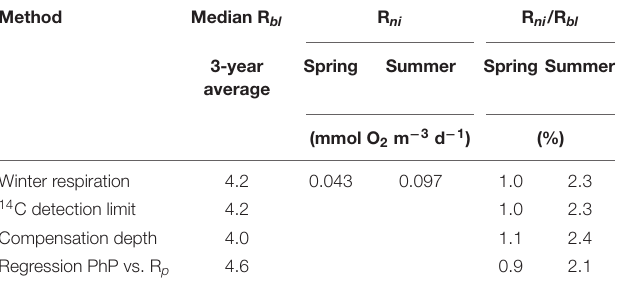
TABLE 3 | Integrated rates for the whole volume of the estuary (0.77 km 3 ) per year or per winter. R p R bl PhP RTOC load